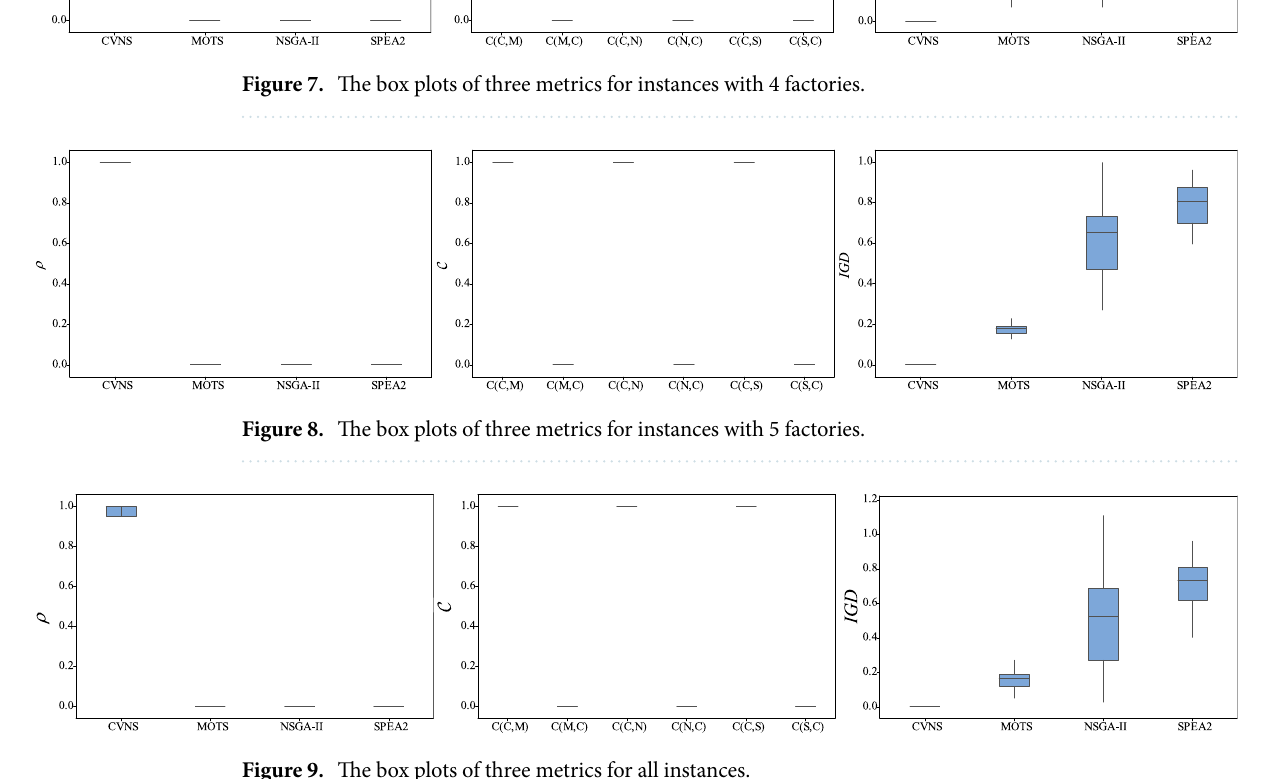
Figure 9. The box plots of three metrics for all